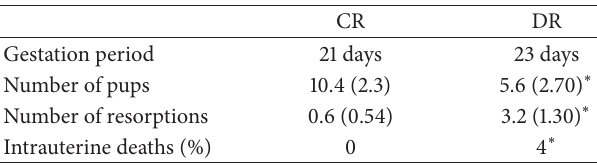
Table 1: Litter characteristics. CR